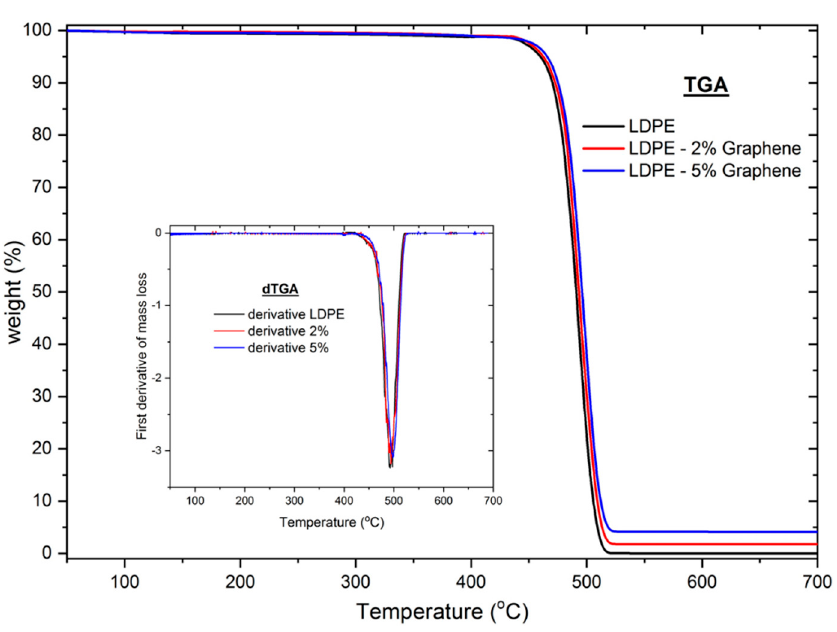
Figure 6. TGA thermal decomposition evolution of pure LDPE, 2% and 5% graphene containing GnPs / LDPE composite materials. Inset: The first derivative of mass loss.